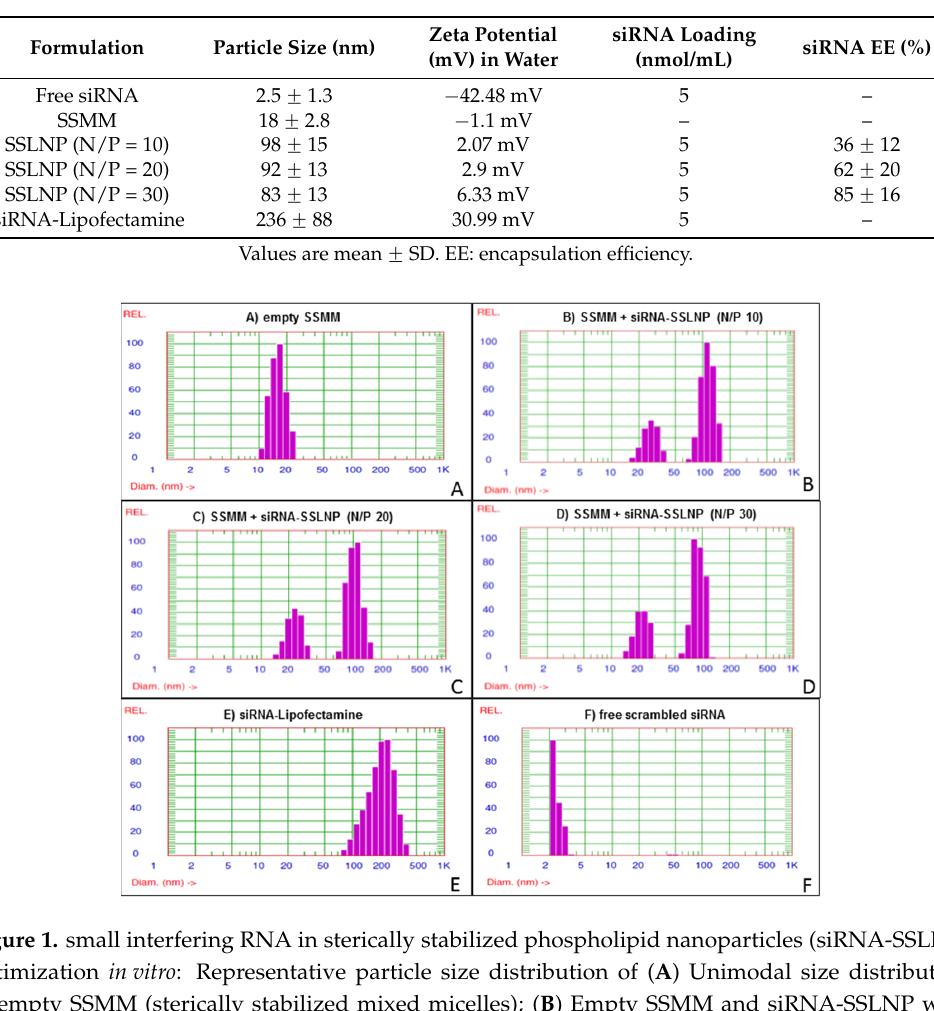
Table 1. Physicochemical properties of small interfering RNA in sterically stabilized phospholipid nanoparticles (siRNA-SSLNP) compared to sterically stabilized mixed micelles (SSMM) and Small interfering RNA- Lipofectamine (siRNA-Lipofectamine). Formulation